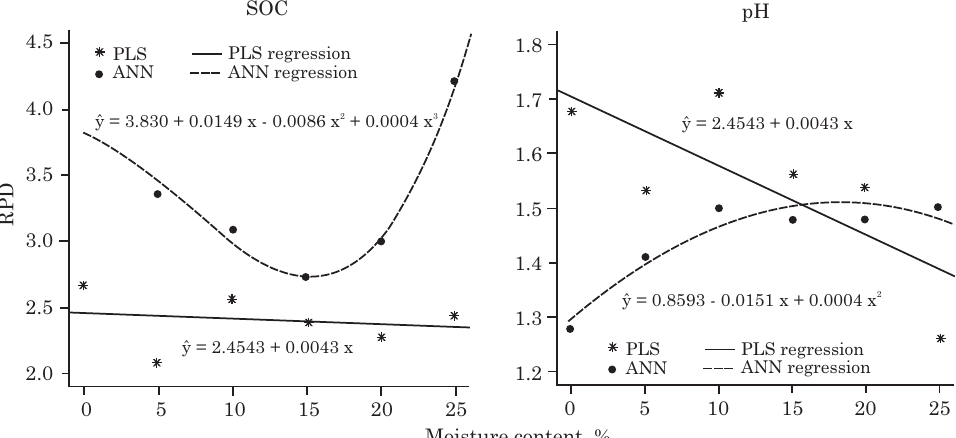
Figure 6. Variations in residual prediction deviation (RPD) with moisture content obtained from partial least squares (PLS) and artificial neural network (ANN)